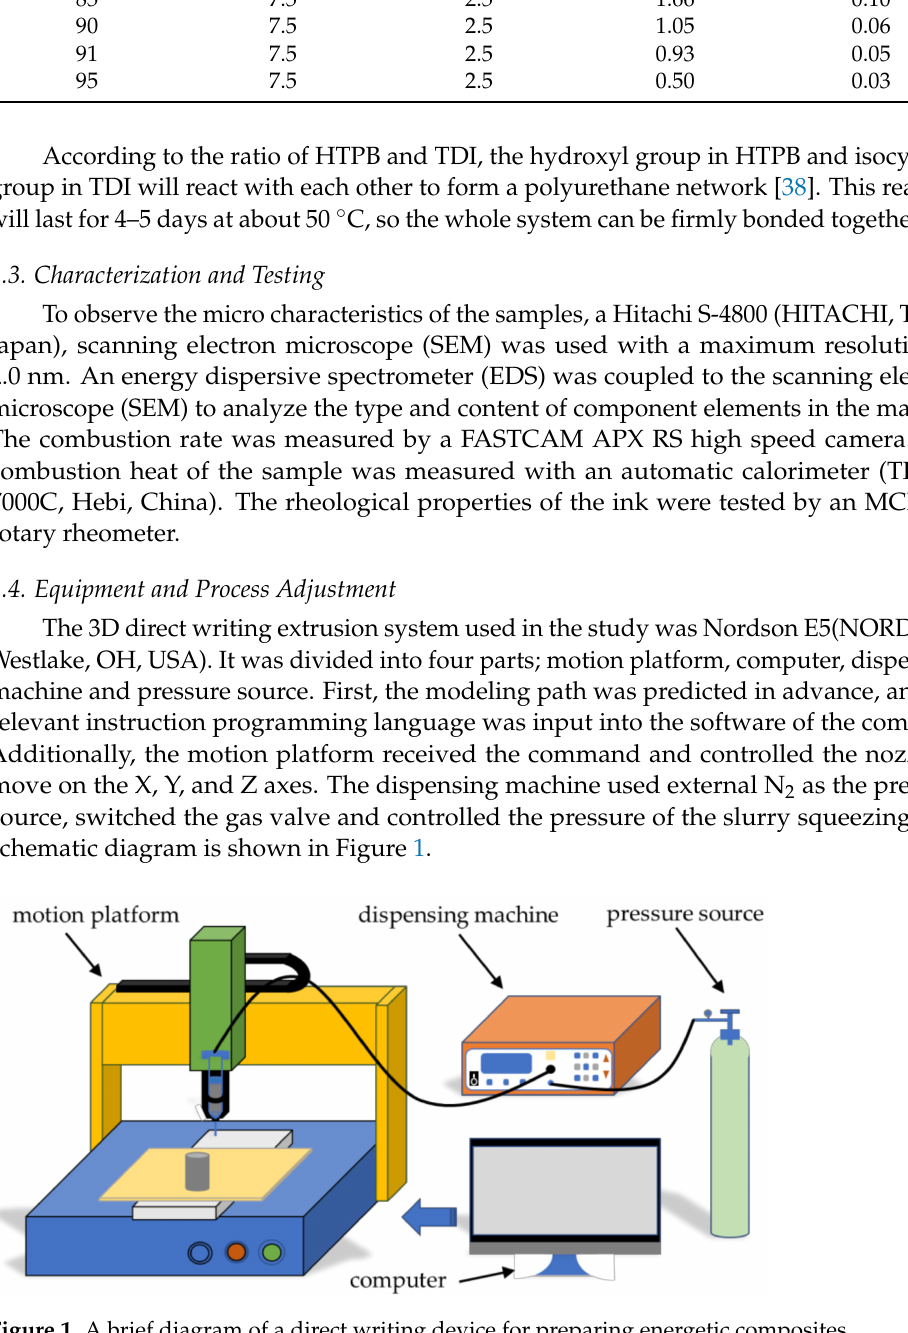
Figure 1. A brief diagram of a direct writing device for preparing energetic composites. The rheological properties of each component are different for various dispersion performances. In the printing process, the process parameters suitable for each component were found, as shown in Table 2. The application of these process parameters means the slurry can be printed continuously and smoothly, presenting a better